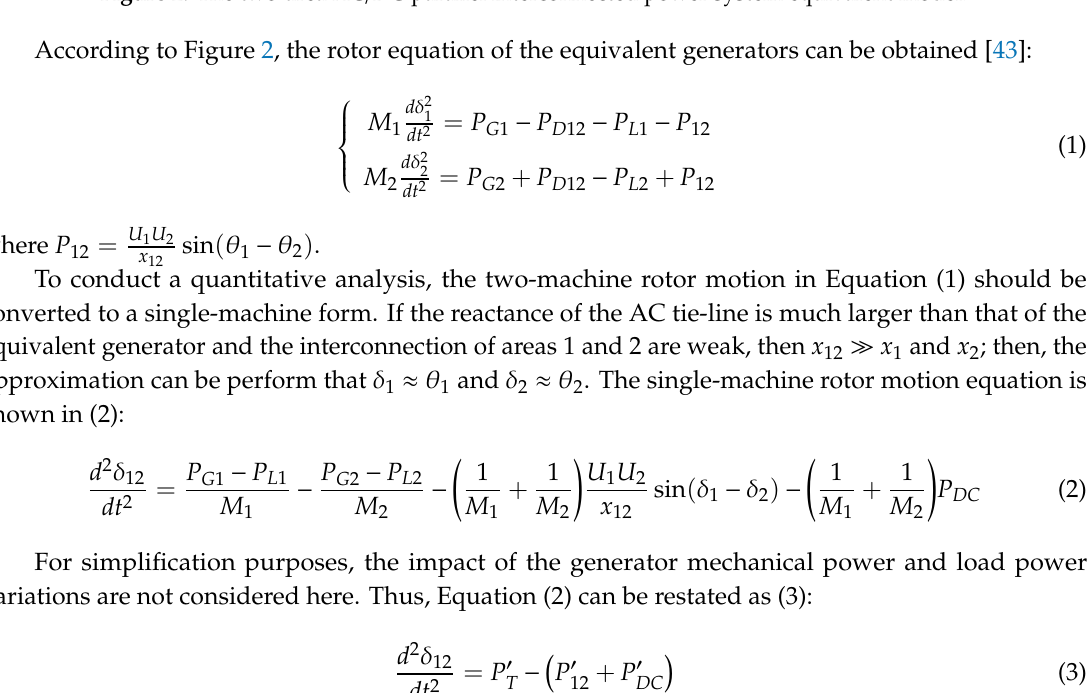
Figure 2. The two-area AC / DC parallel interconnected power system equivalent